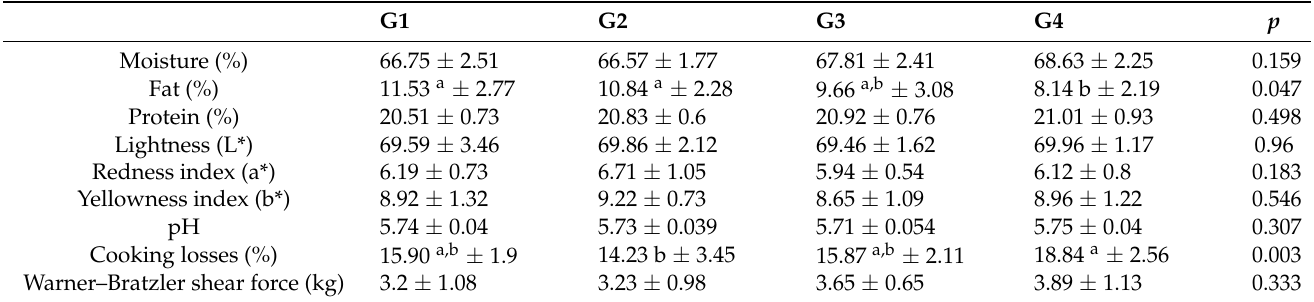
Table 6. Proximate composition and instrumental quality parameters (mean ± standard deviation) of longissimus thoracis muscle from dietary experimental groups.